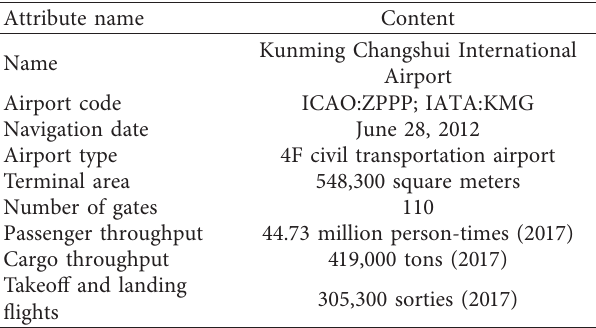
Table 4: Basic information of Kunming Changshui International Airport.